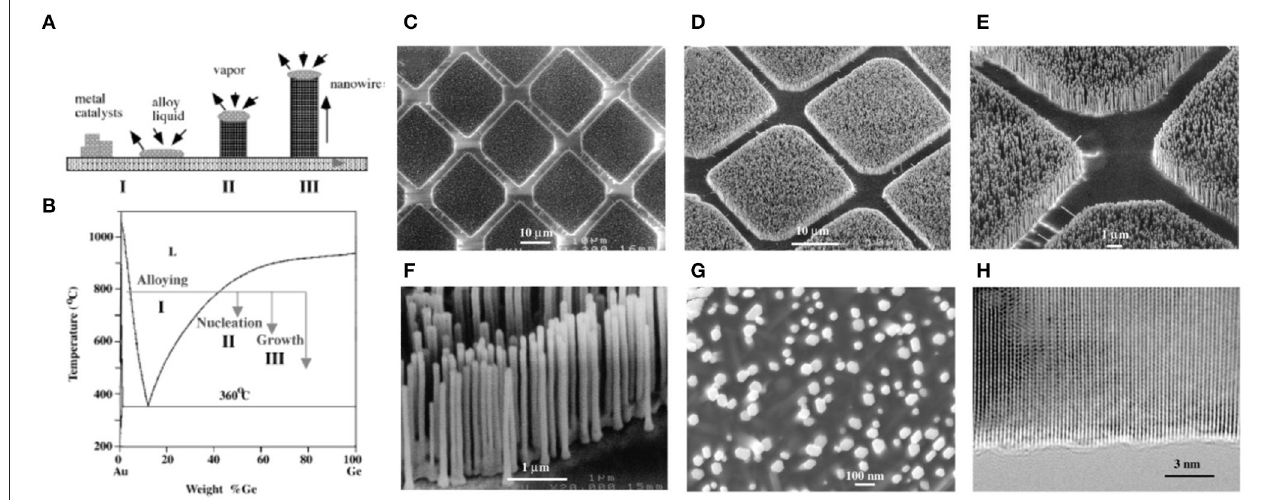
FIGURE 1 | (A) Three stages of the vapor-liquid-solid nanowire growth mechanism. The three stages are projected onto the conventional Au-Ge binary phase diagram (B) to show the compositional and phase evolution during the nanowire growth process. (C–G) Scanning electron microscope (SEM) images of ZnO nanowires grown on sapphire substrates. (H) High-resolution transmission electron microscope image of an individual ZnO nanowire showing its < 0001 > growth direction. Scale bar (C–H) : 10, 10, 1, 1, 100, and 3nm. (A,B) Reproduced with permission. Wu and Yang (2001) Copyright 2001, American Chemical Society. (C–H) Reproduced with permission. Huang et al. (2001) Copyright 2001, American Association for the Advancement of Science.